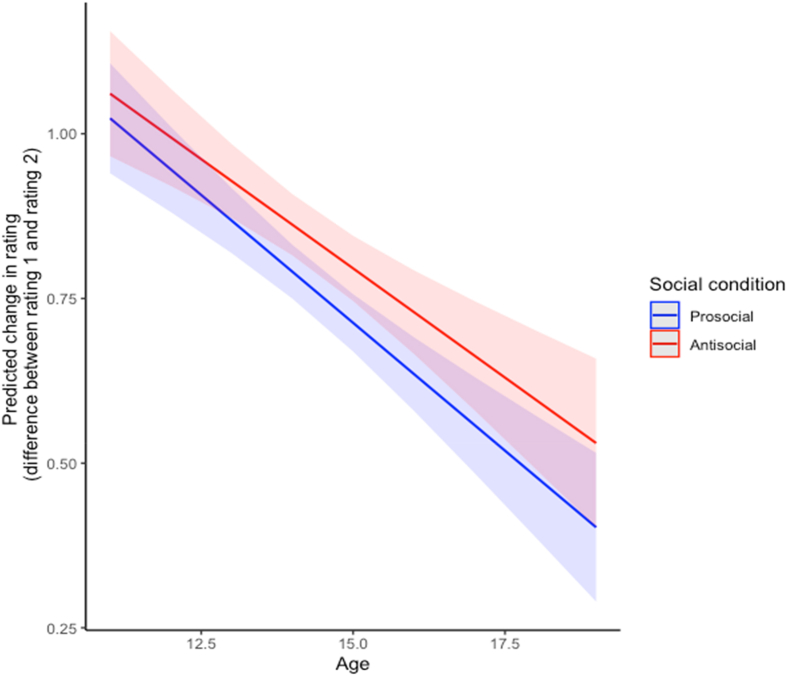
Predicted values for the average change in prosocial and antisocial rating predicted by the difference between the provided rating and the first rating (Δrating), shown across age. The slopes were calculated using estimates of the linear mixed-effect models.